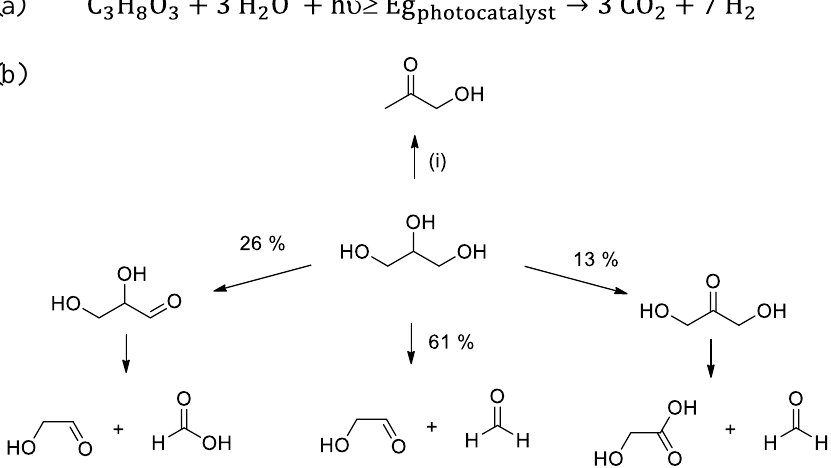
Figure 1. ( a ) Stoichiometry of glycerol photoreforming. ( b ) Proposed initial reaction sequences of glycerol photoreforming using Rh/TiO 2 . Note: Light-driven dehydration to hydroxyacetone constitutes a side reaction (i)